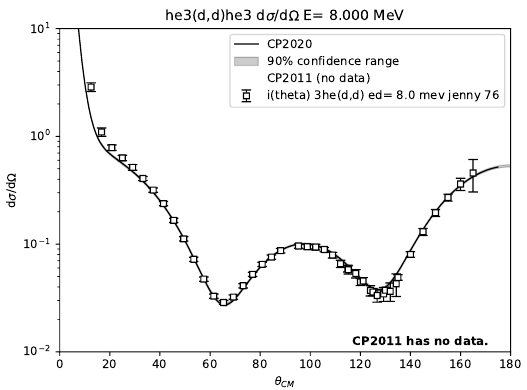
Figure 4. The angular distribution for 3 He( d , d ) 3 He for deuteron incidentlaboratoryenergy8.0MeVoftheunpolarizeddifferential cross section in the center of mass as a function of the center of mass angle θ cm . The evaluation is shown by the solid curve. The gray band is the 90% confidence interval determined as described in the text.